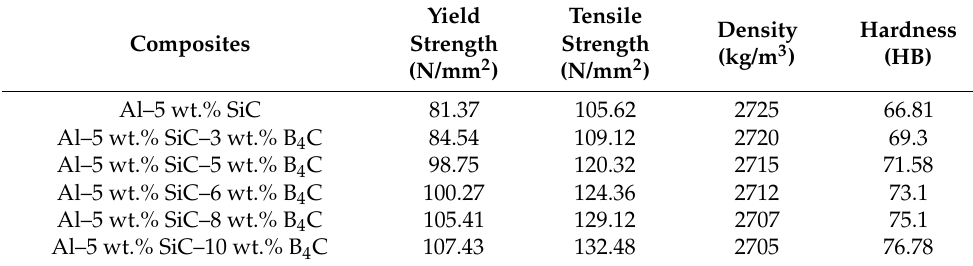
Table 13. Material composition of Al6351–5% SiC composite with different percentages of B 4 C.